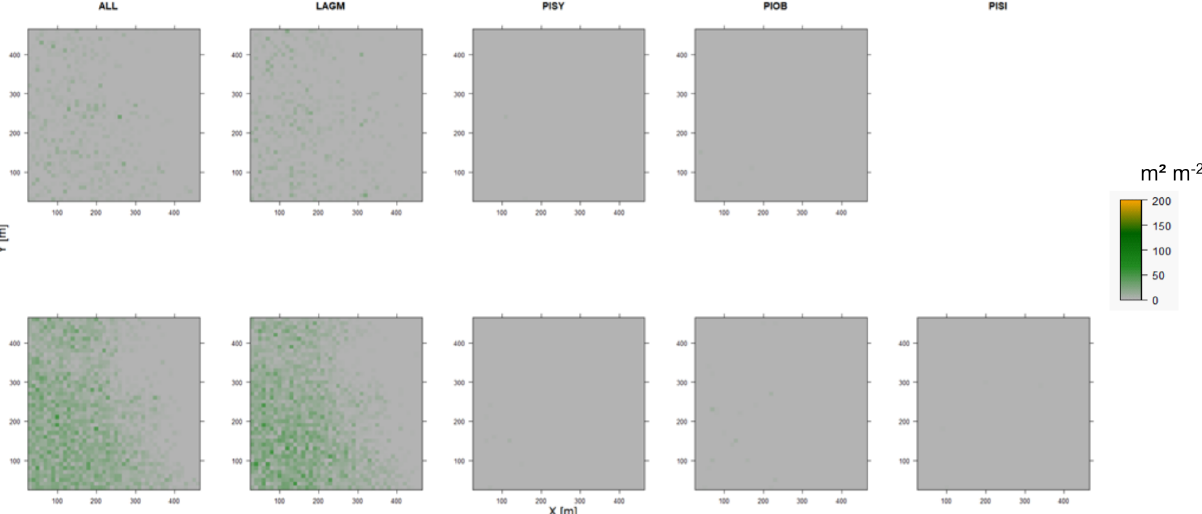
Figure D12. Leaf area index (LAI) values of the CryoGrid grid aggregated at year 2030 at Spasskaya Pad. Upper row shows LAVESI– CryoGrid coupled; lower row shows LAVESI simulations. LAGM: Larix gmelinii ; PIOB: Picea obovata ; PISI: Pinus sibirica ; PISY: Pinus sylvestris . Simulations with PISI coupled were not